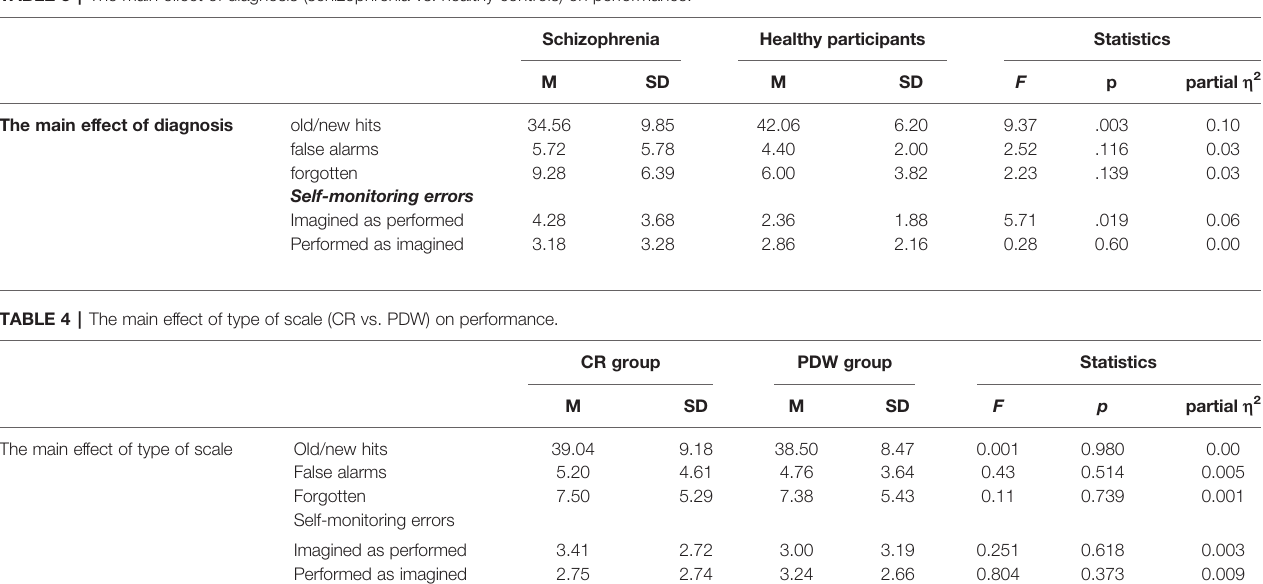
TABLE 3 | The main effect of diagnosis (schizophrenia vs. healthy controls) on performance.